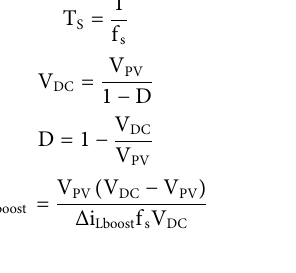
FIGURE 2 PV array